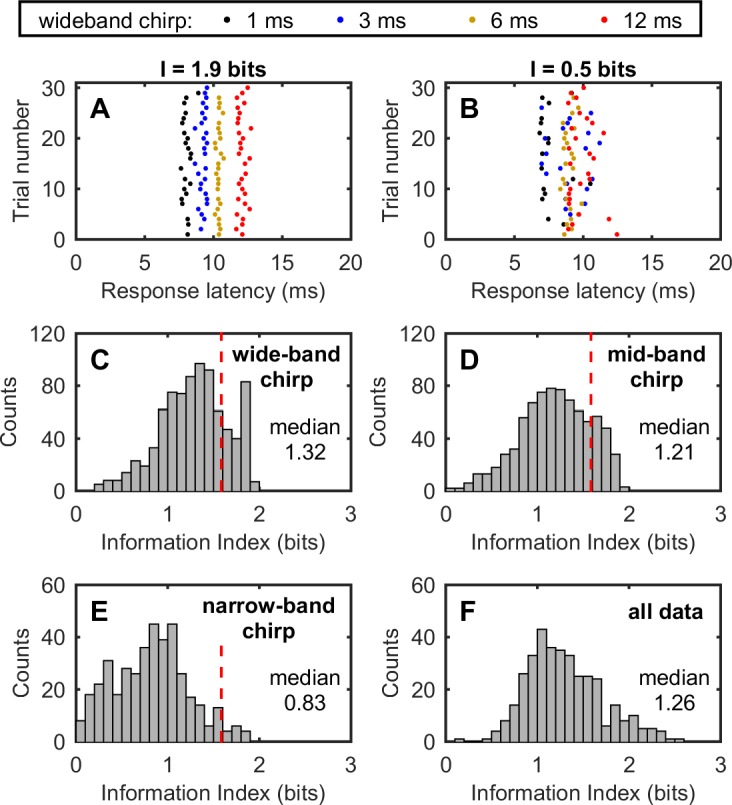
Information analysis of the timing of the EFP (200–600 Hz) evoked by simulated echolocation calls of different duration and bandwidth.(A, B) Two examples illustrating the mutual information calculated for wideband chirps (first harmonic, 25–55 kHz) of four different durations, i.e., 1 ms, 3 ms, 6 ms, and 12 ms. A mutual information of 1.9 bits in A shows that all four types of chirps can be distinguished nearly perfectly by the EFP response latency alone. By contrast, a mutual information of 0.5 bits in B shows that the four types of chirps cannot be categorized by the EFP response latency. Of note, a mutual information of 1 bit and 3 bits mean that two and eight types of signals can be distinguished, respectively. (C–F) Distribution of the mutual information calculated for the wideband chirps, midband chirps, narrowband chirps, and all chirp types, respectively. A median mutual information of 1.32 and 1.28 for the wideband chirps and the midband chirps indicates that the EFP response latency encodes substantial information about the duration of the chirps. Data for this figure are included in S1 Data. EFP, extracellular field potential.